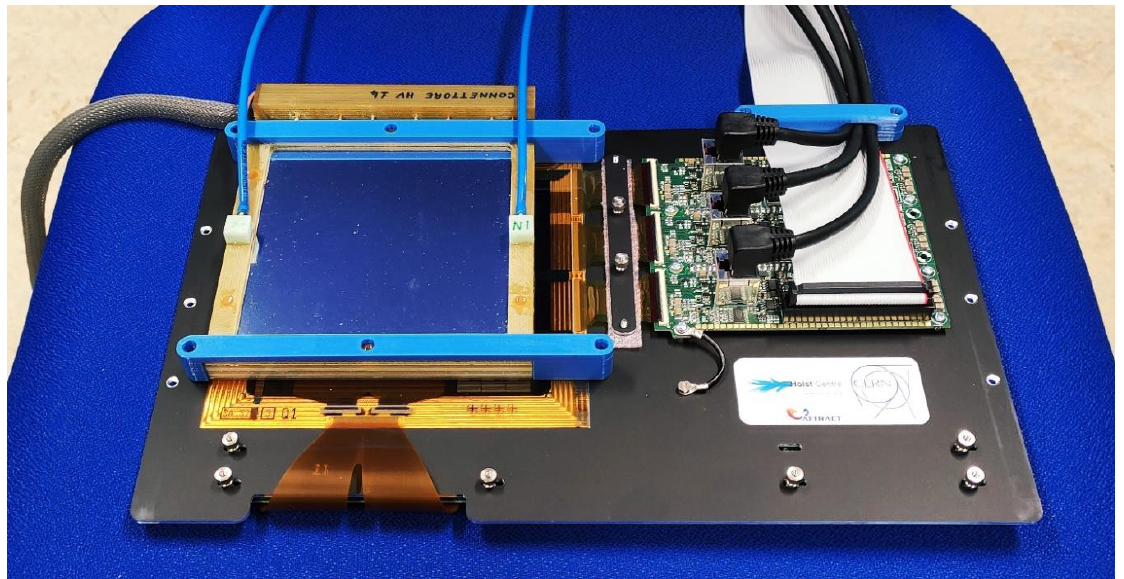
Figure 16. The LaGEMPix prototype. The triple GEM 10 × 10 cm 2 stack coupled to the optical readout matrix is on the left side; on top, there is the thin Mylar window. The readout boards and the cables to connect the detector to the FPGA module are on the right side.